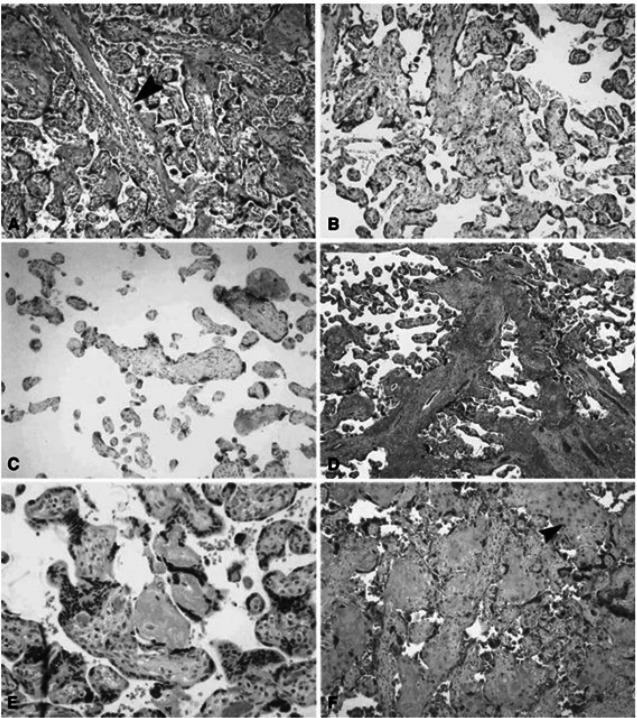
Histologic features of villous and intervillous lesions.(A) Increased syncytial knots: aggregates of syncytiotrophoblast nuclei cluster at one or more poles of distal villi in the vicinity of larger stem villi (arrowhead) at the periphery of the lobule ([original magnification is indicated for all panels] X 10). (B) Villous agglutination: clusters of degenerating distal villi are adherent to one another and focally enmeshed in fibrin (X 4). (C) Distal villous hypoplasia: a long, thin, non-branching stem villus is surrounded by a markedly reduced number of small hypoplastic distal villi (X 10). (D) Increased intervillous fibrin: stem villi are surrounded by a mantle of fibrin-type fibrinoid that does not extend to distal villi at the center of the lobule (X 2). (E) Nodular intervillous (and intravillous) fibrin: small aggregates of intervillous fibrin adhere to, and are focally reepithelialized by, distal villous trophoblast (X 20). (F) Increased intervillous fibrin with intermediate trophoblast (X-cells): stem and distal villi are enmeshed in a matrix of fibrin and fibrinoid containing prominent intermediate trophoblast (arrowhead) (X 10). From Redline et al. (2004).